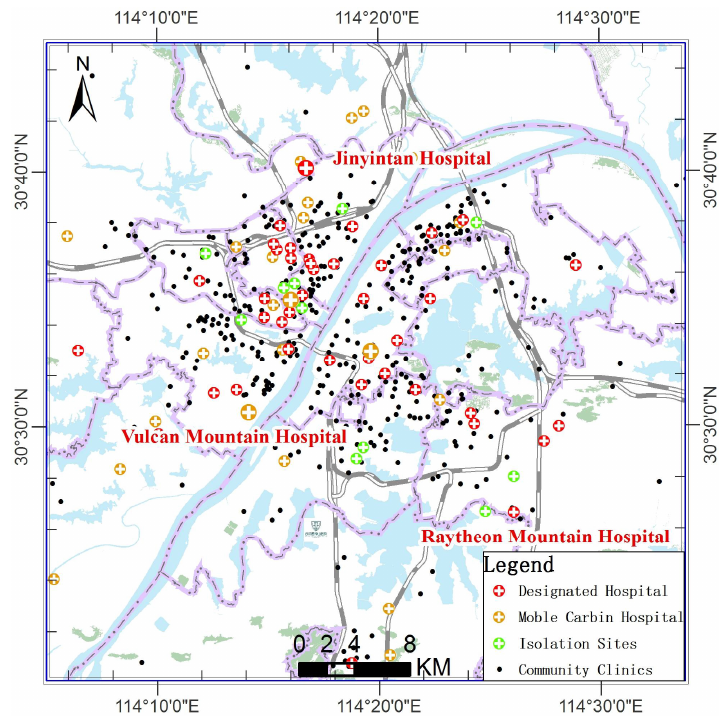
Figure 14. The distribution of major medical facilities in Wuhan. The changes of the population heat values in the designated COVID-19 hospitals are shown in Figure 15. The population thermal change of the Vulcan Mountain Hospital, the Raytheon Mountain Hospital, the Jinyintan Hospital, and other specialized hospitals are obvious, which is obviously higher in February and gradually decreased after March. Some general hospitals, such as the Central South Hospital, the Tongji Hospital, the Zhongfa New Town Campus, and the People’s Hospital, continued receiving and treating newly confirmed patients during the whole epidemic period. As a result, the population heat value changes of these hospitals are not obvious. After the Hubei Maternal and